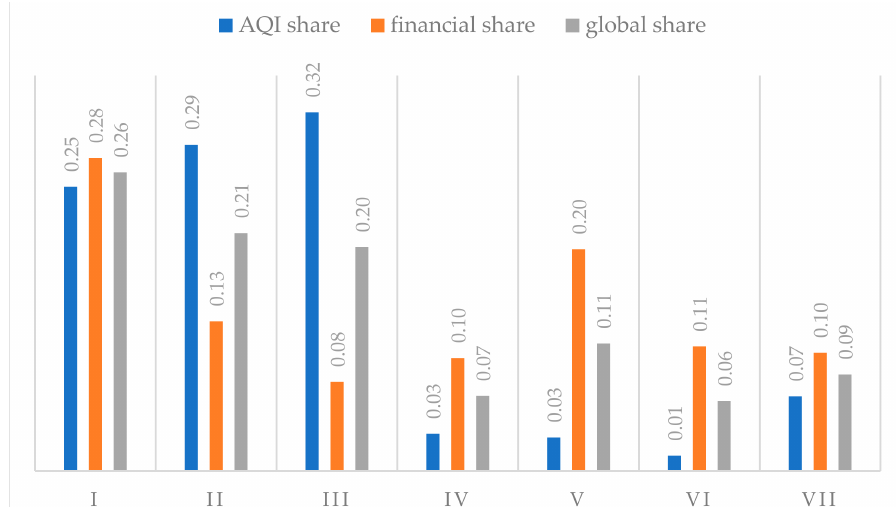
Figure 9. The AQI share, financial share of individual installations and the total impact of both factors as a global share for the installation operating time of 1000 h over 20 years of use, where: I—electric heating power supply, II—liquid heating supplied from the district heating network, III—liquid heating powered by a hard coal boiler, IV—liquid heating powered by a biomass boiler, V—liquid heating with fuel oil boiler, VI—liquid heating powered by a natural gas boiler, VII—liquid heating powered by a ground source heat